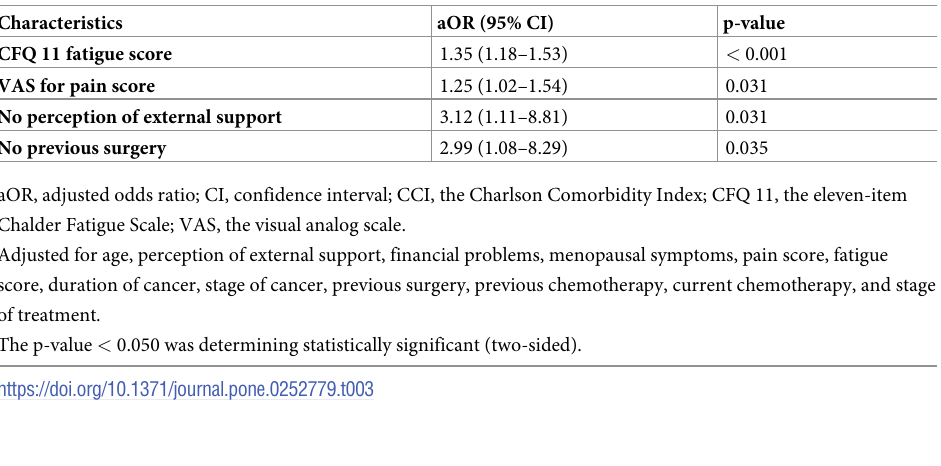
Table 3. Multivariable logistic regression for independent associated factors of depressive disorder among cervi- cal cancer